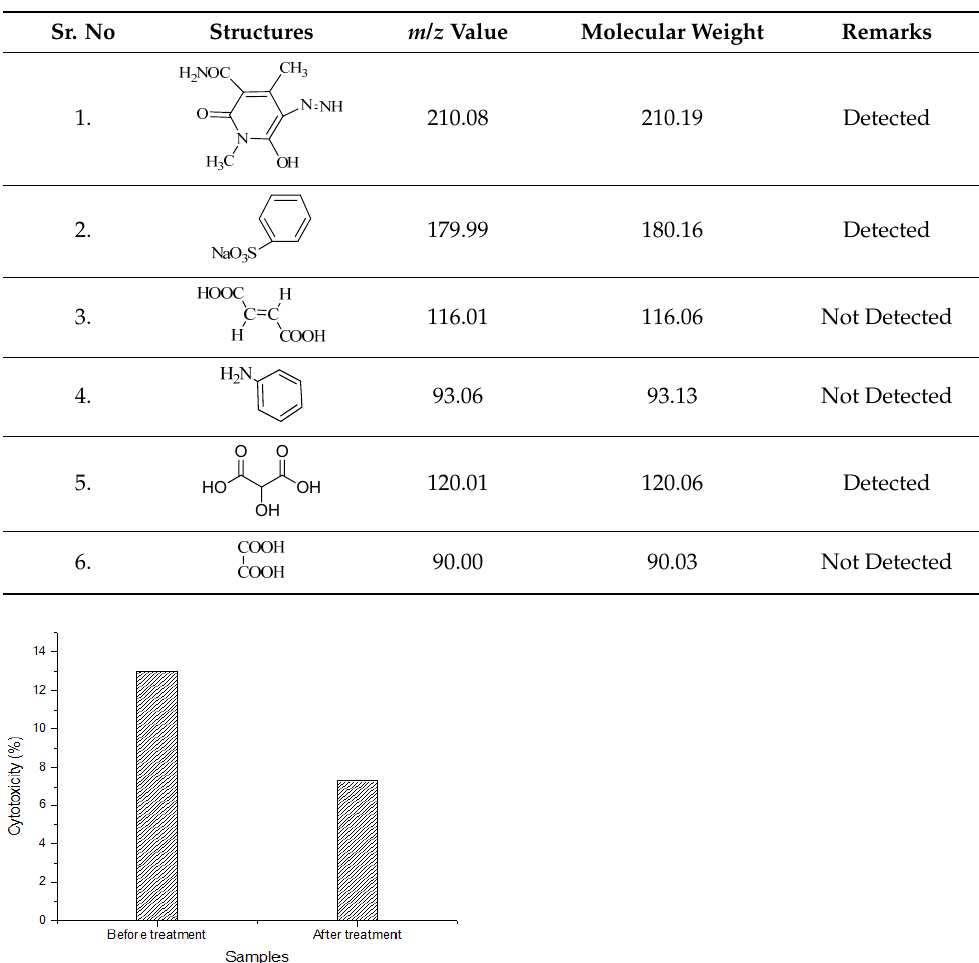
Figure 10. Proposed general mechanism for degradation of Reactive Yellow 160A. Table 2. Degradation intermediates of Reactive Yellow 160A identified by LC-MS.